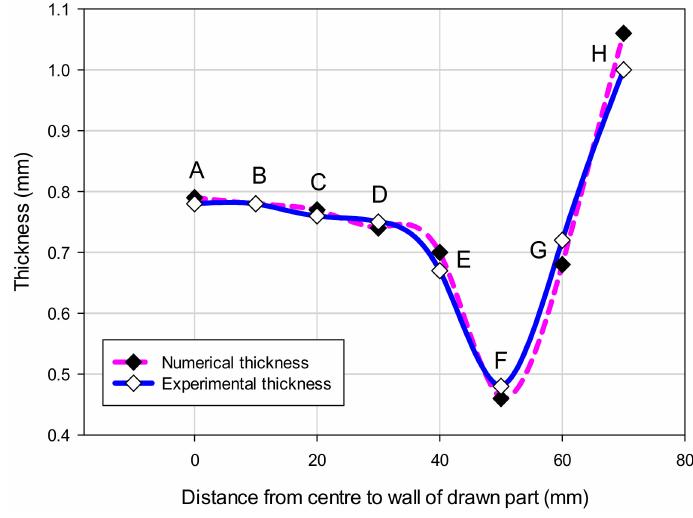
Figure 9. The thickness comparison of numerical and experimental results.